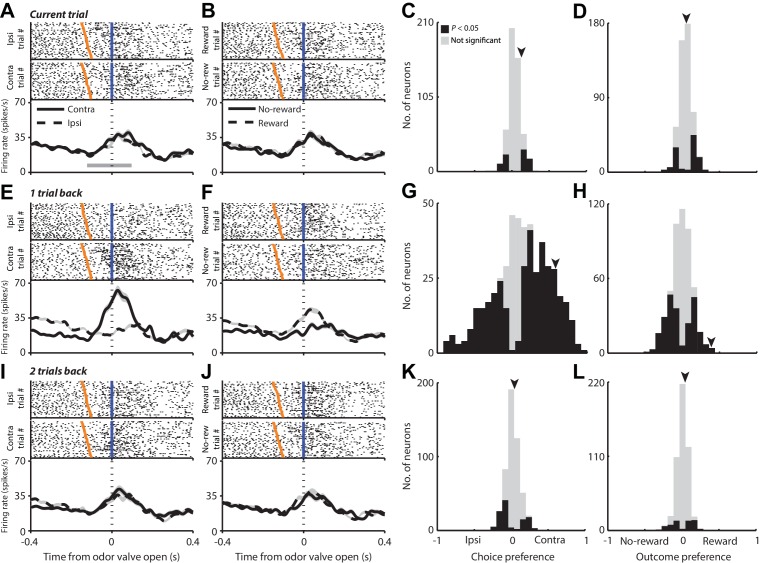
PPTg activity during the pre-stimulus epoch is influenced by choices and outcomes on previous trials.(A and B) Rasters (top) and PSTHs (bottom) for one example neuron grouped by choice (A) and outcome (B) on the current trial. Fifty pseudorandomly selected ipsilateral and contralateral trials (A) and reward and no-reward trials (B) are shown in the rasters; all trials are included in the PSTHs. Activity is aligned to the time of odor valve open (blue lines) and sorted within each group by the time since odor port entry (orange ticks). PSTHs show average firing rate across all trials in each group, smoothed with a Gaussian filter (σ = 15 ms). Shading, ± s.e.m. Gray bar shows mean pre-stimulus epoch. (C and D) Preference during the pre-stimulus epoch for choice (C) and outcome (D) on the current trial across the population of neurons. Arrowheads indicate preferences for example neuron shown in A and B. (E, F, G and H) As in A, B, C and D with respect to 1 trial back instead of current trial. Data from same example neuron are shown. (I, J, K and L) As in A, B, C and D with respect to two trials back instead of current trial. Data from same example neuron are shown.